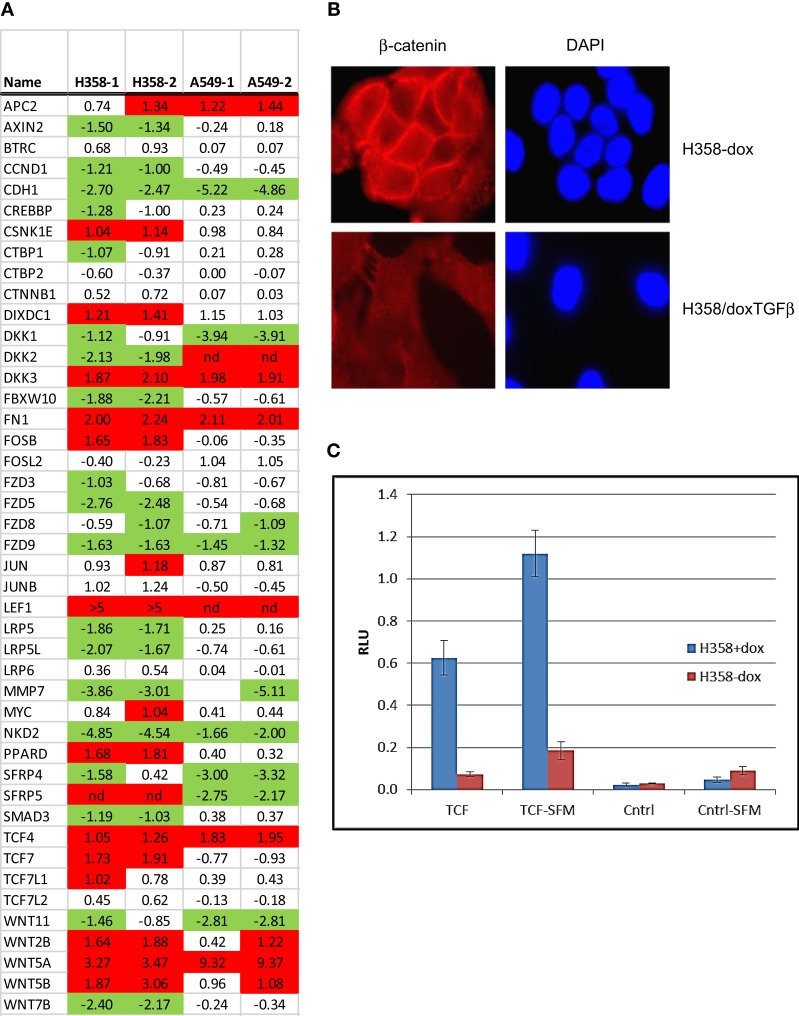
Nuclear translocation of β-catenin and TCF/LEF activation in steady-state mesenchymal H358 cells expressing Wnt5A. (A) Heat map of RNA abundance of Wnt signaling components and target genes in H358 and A549 isogenic models (mesenchymal/epithelial; log2) from duplicate samples. (B) Loss of membrane β-catenin localization and gain of punctate nuclear localization in mesenchymal H358/dox-TGFβ cells. Top panels: H358 cells in the absence of doxycycline. Bottom panels: H358/dox-TGFβ cells in a mesenchymal-like state. Cells were labeled with β-catenin antibody (red) and DAPI (blue) and imaged (60X). (C) Co-transfection of sTOP-TCF/LEF-luciferase (“TCF”) or control FOP-luciferase (“Cntrl”) was used to measure the activity of the TCF–LEF pathway. Renilla-luciferase was used to normalize transfection efficiency. H358/dox-TGFβ cells, in the presence or absence of doxycycline, were transfected and after 48 h luciferase measurements preformed under standard conditions. Both steady-state serum and 24 h serum starvation conditions (“-SFM”) were used with similar results. The y-axis units are relative light units (RLU). The means of two independent experiments are shown, each in triplicate, where the error bars reflect the standard error of the mean.